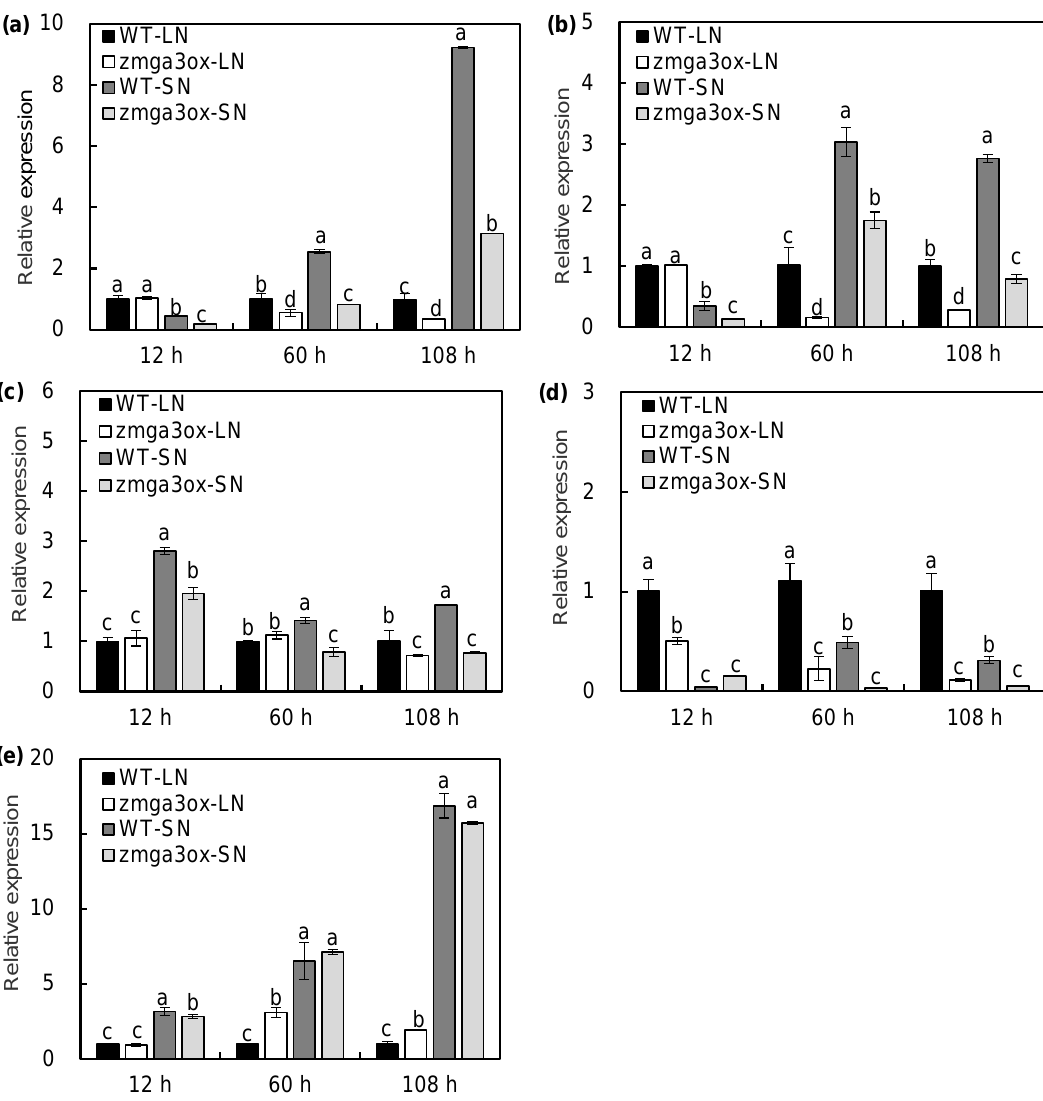
Figure 7. The expression levels of ZmNRT2.1 ( a ), ZmNRT2.2 ( b ), ZmNPF6.4 ( c ), ZmNPF7.3a ( d ), and ZmNPF6.3b ( e ) in wild-type and zmga3ox roots under LN and SN conditions. Roots were harvested at 12, 60, and 108 h after LN and SN treatments. Values were the means ± SD (n = 3). Different letters indicated significant difference between the wild-type and zmga3ox plants at the same time point calculated by Fisher’s LSD ( p < 0.05).